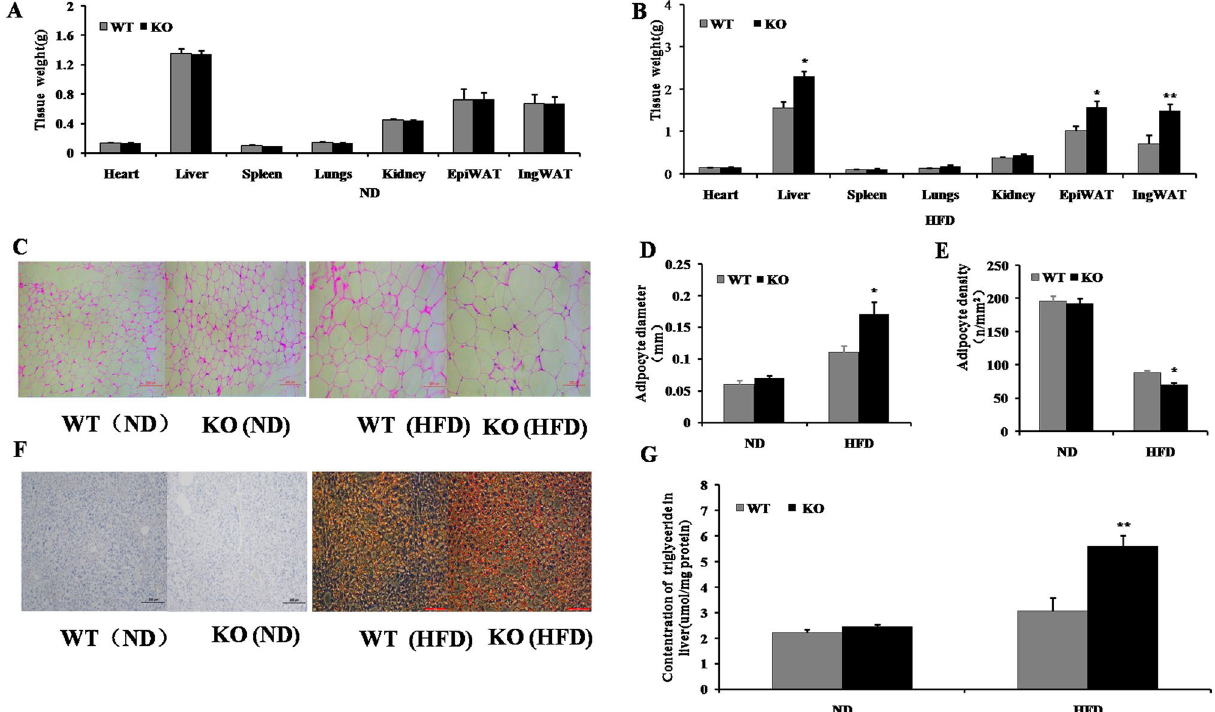
Figure 2. MiR-125b-2 knockout increased the weight of liver, EpiWAT, and IngWAT tissue, and increased adipocyte volume and diameter in HFD-induced obese mice. ( A ) The weight of tissues and organs from WT and KO mice fed ND or ( B ) HFD. ( C ) IngWAT adipocyte volume, ( D ) diameter, and ( E ) adipocyte density in WT and KO mice fed ND or HFD. ( F ) Lipid droplet number and ( G ) Liver triglycleride contents in WT and KO mice fed ND or HFD. Data are presented as mean ± SE (* P < 0.05, ** P < 0.01.) Microscope images C and F are representative images, Scale bar: 100 × magnification, 200 μm; n = 24 photos per animal / per group, n = 8 mice per